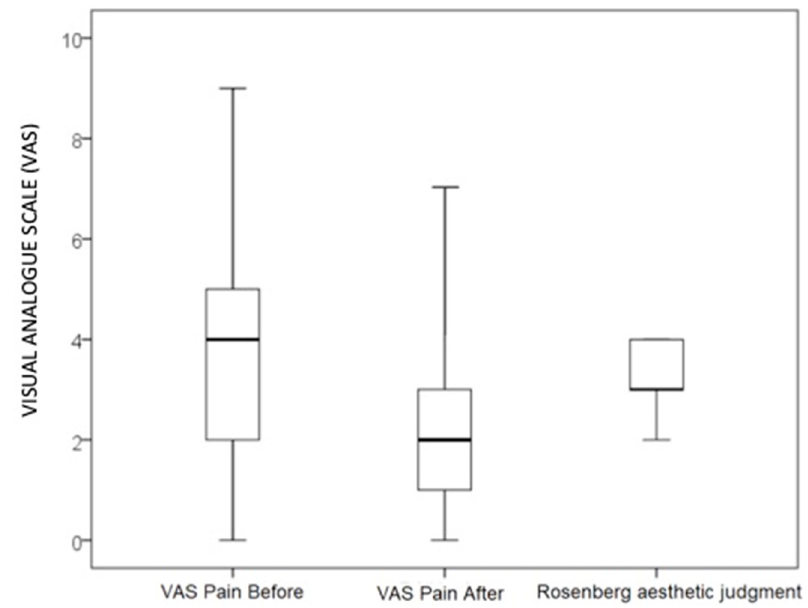
Chart 3. Visual analogue scale (VAS). Box whiskers plot reporting median (bold line), minima (lower line), first and third quartiles (borders of the boxes) and fourth quartiles (borders of whisker) of VAS-score about pain before and after intervention and the aesthetic judgment given using Rosenberg-scale.